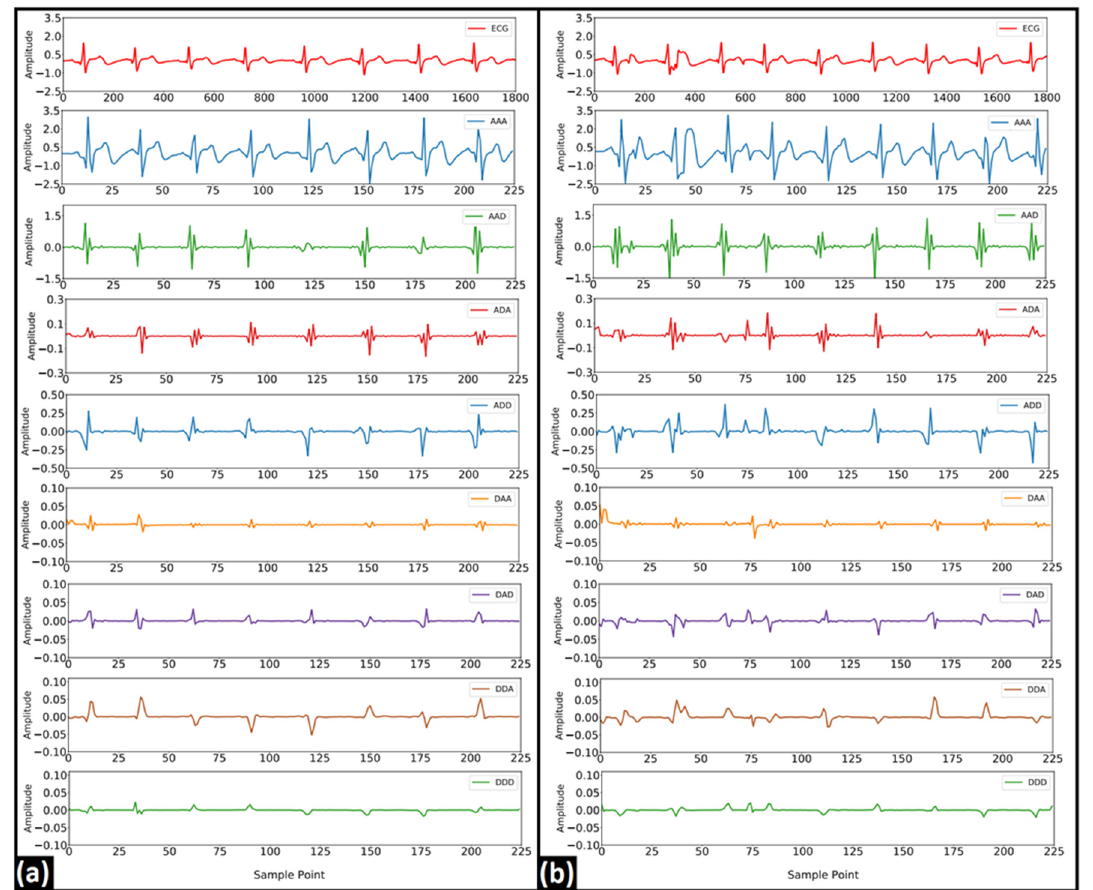
Figure 10. Typical WPD coefficients after level-3 decomposition using db6 mother wavelet ( a ) before and ( b ) after consumption of coffee.